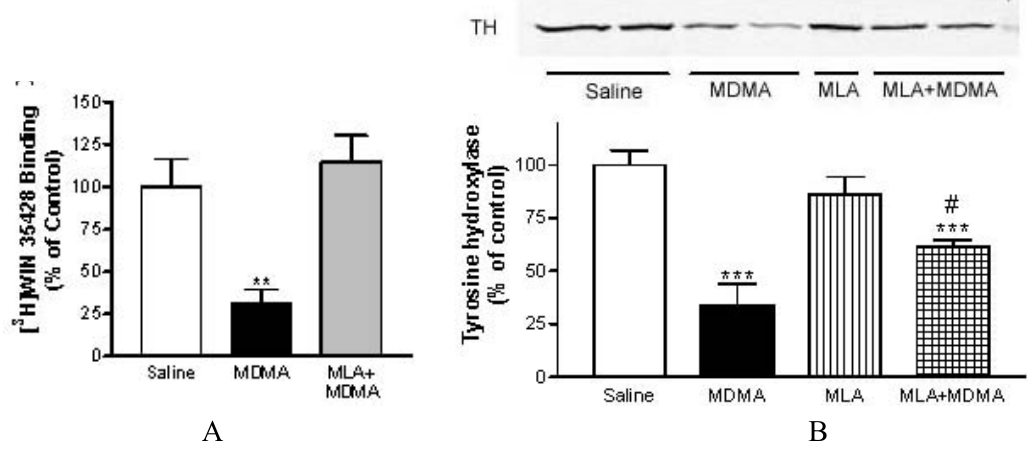
Figure 5. Protective effects of MLA on striatal dopaminergic neurotoxicity in mice treated with MDMA. The loss of dopamine transporters was quantified by [ 3 H]WIN 35428 binding (panel A) and the dopamine impairment was measured by Western blotting (panel B) using a primary antibody against tyrosine hydroxylase (reproduced from